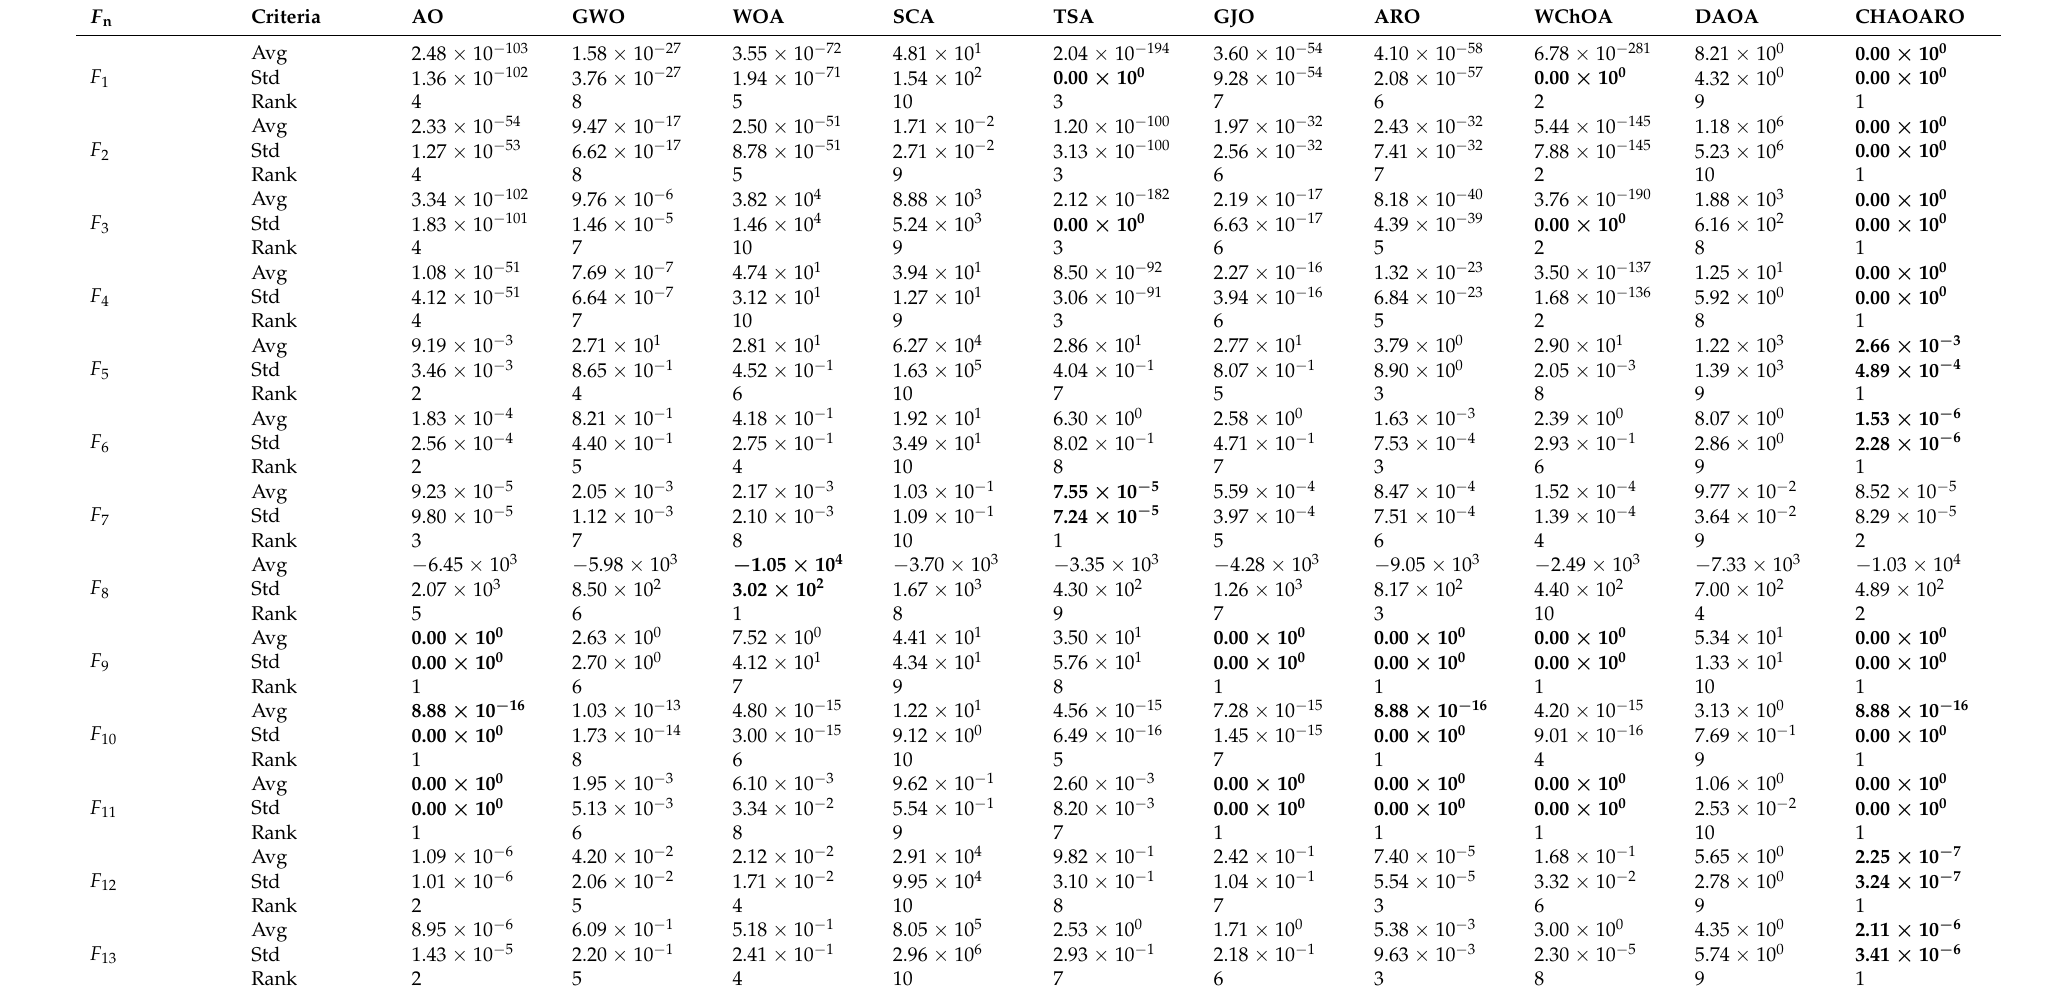
Table 6. Comparison results of CHAOARO and other algorithms on 23 benchmark